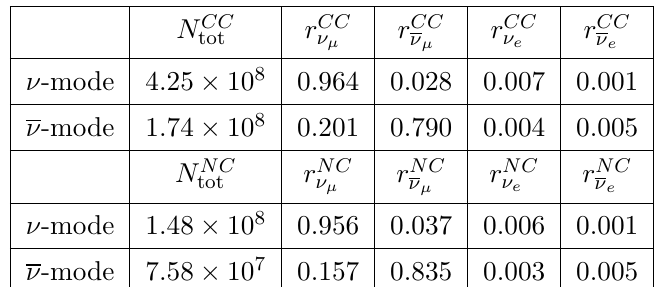
Figure 1 . Orange: projected 95% CL constraints on the wEFT parameters (cid:14)g 2211 eq. (2.1) from elastic neutrino scattering on electrons in DUNE ND, assuming the measurement errors will be dominated by statistics. The dashed line shows the analogous constraints assuming 1% systematic error on the R i measurements. The green region is allowed by the past (cid:23) (cid:22) - e scattering (cid:23)e experiments [14].